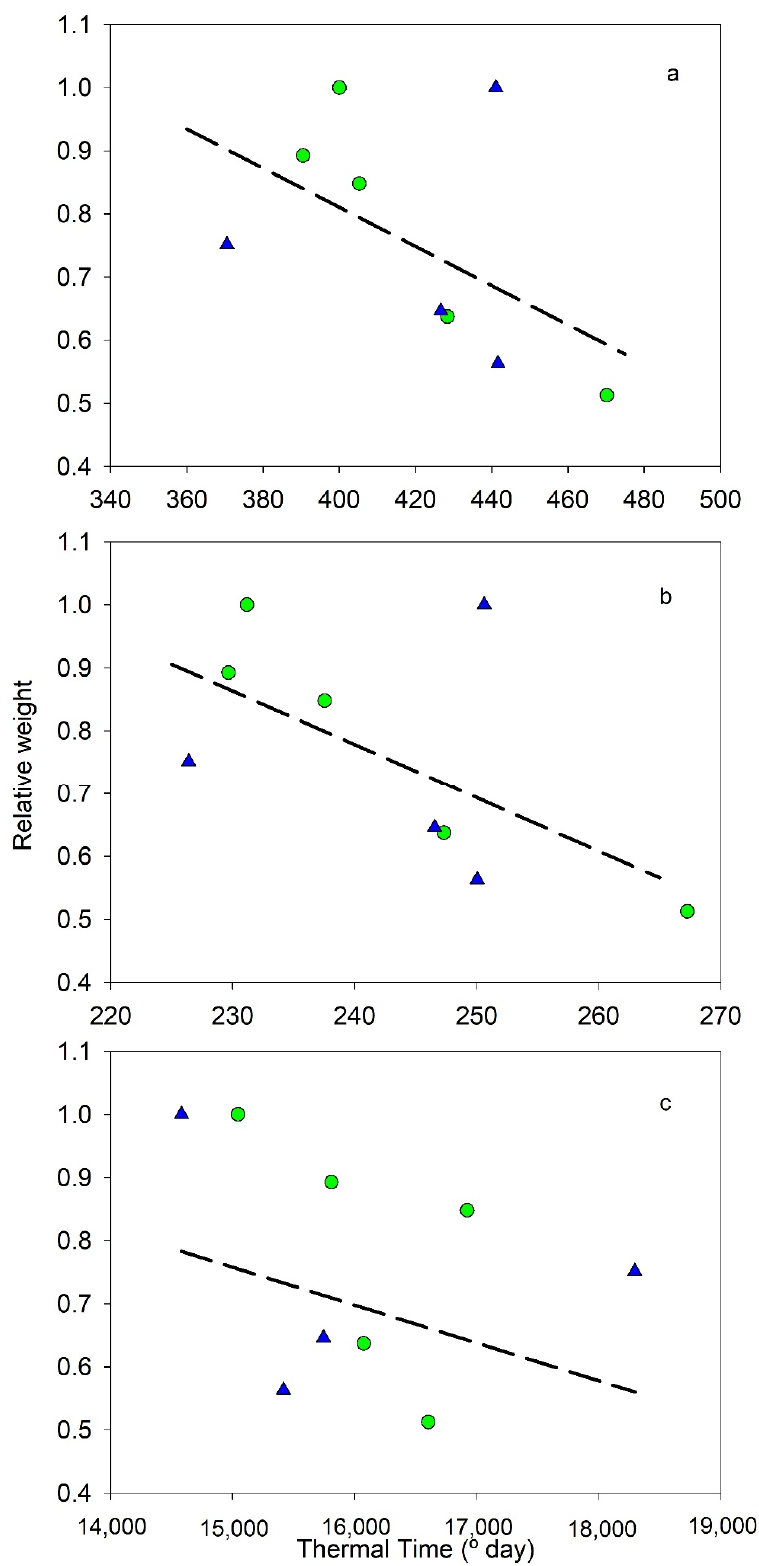
Figure 1. Relationship between relative fruit weight at the end of Period I of endocarp development and the three thermal time models ( a ) Lineal, ( b ) Exponential, ( c ) Cosine. Green circle, cv Cornicabra; blue triangle, cv Arbequina. Lines represent the best fit using all data. Each weight data are the average of the values obtained in each